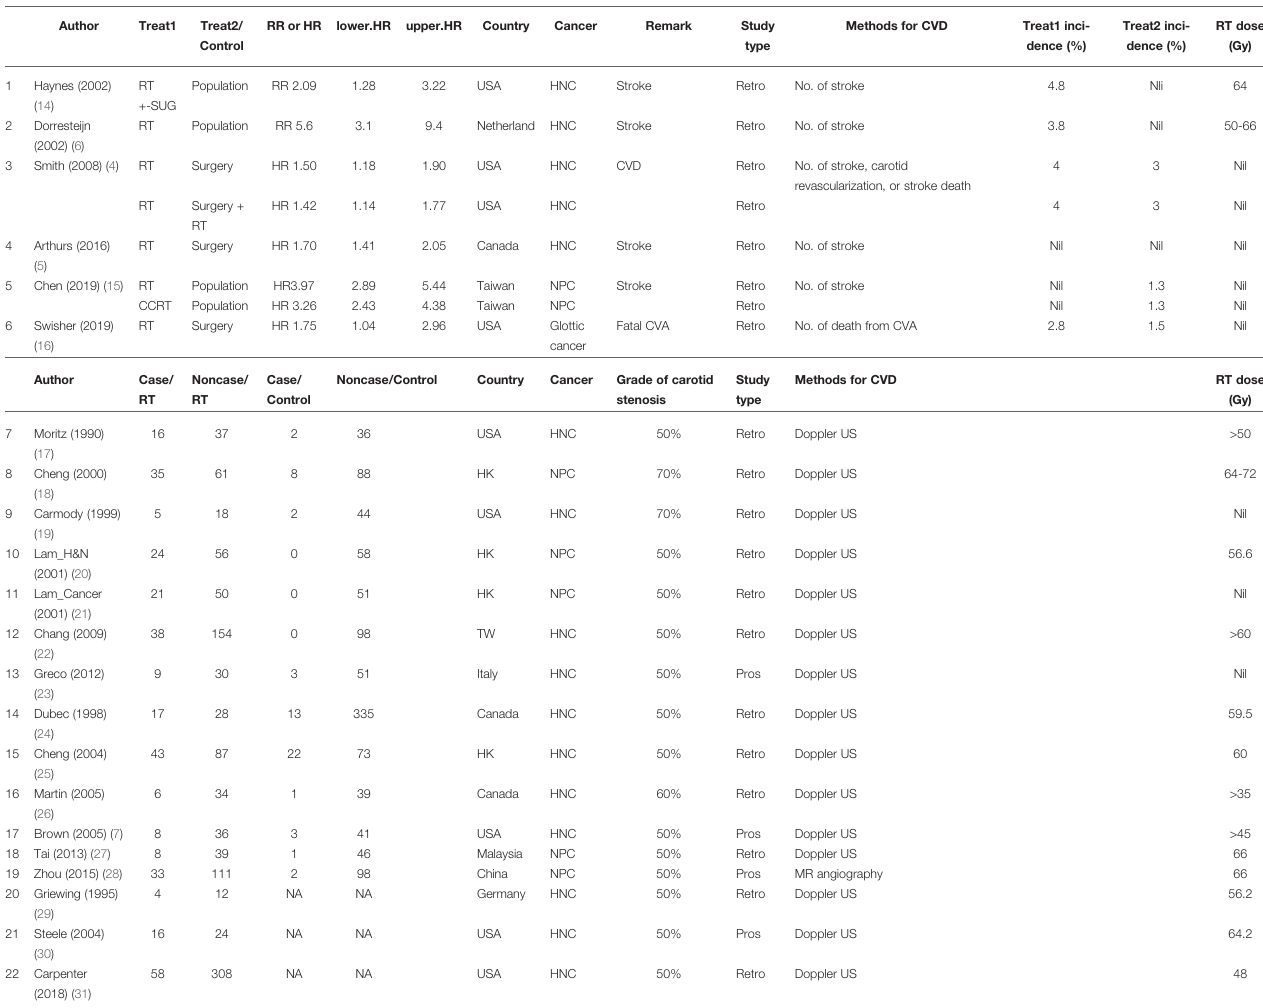
TABLE 1 | Summary of the 22 included studies.